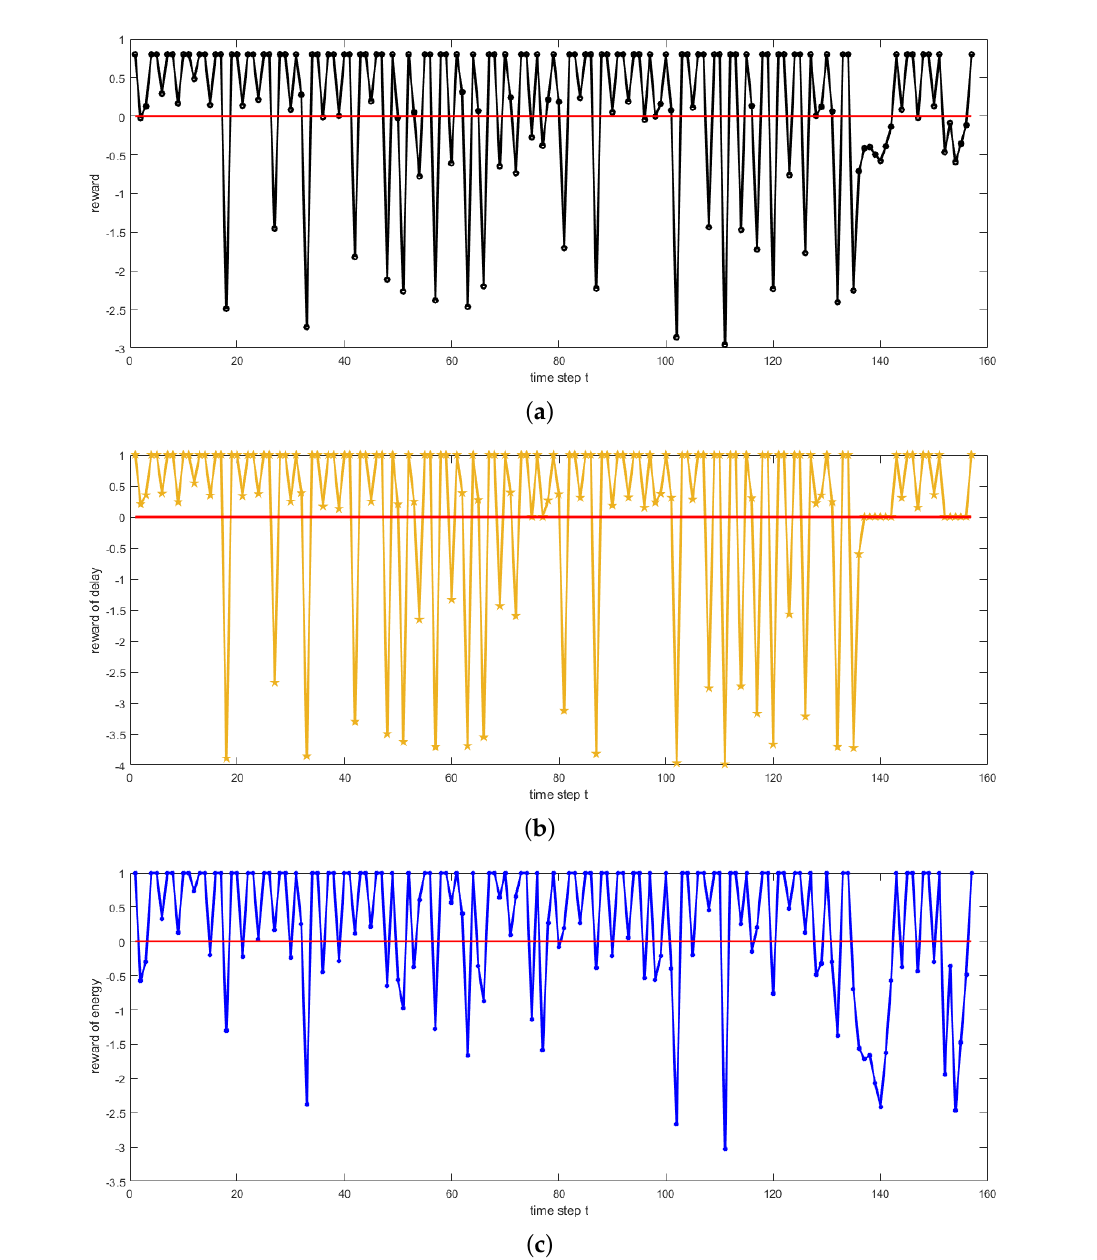
Figure 4. Reward of each time step t . ( a ) represents the figure of R combi values that is a combination of R delay , R energy , and R capacity . ( b ) is a graph of R delay per time step, ( c ) is about R energy